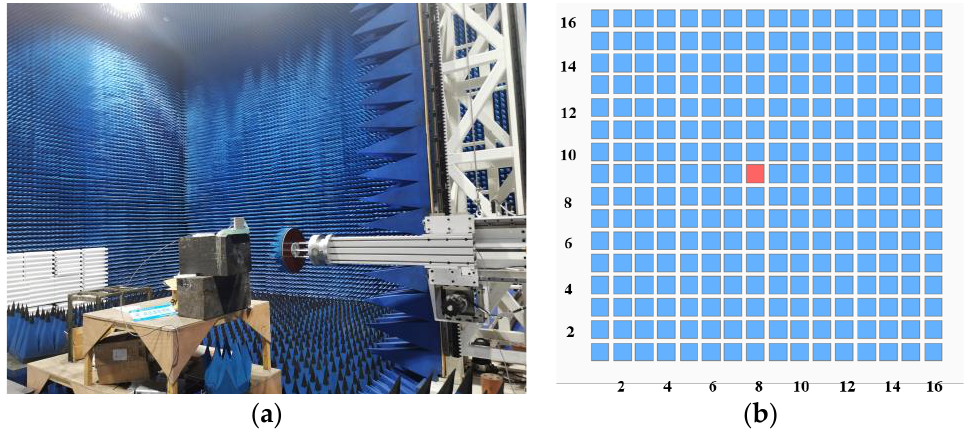
Figure 6. Pattern measurement of the central port ( a ) PUMA array in an anechoic chamber during PNT ( b ) excitation indication in a 256-port array.